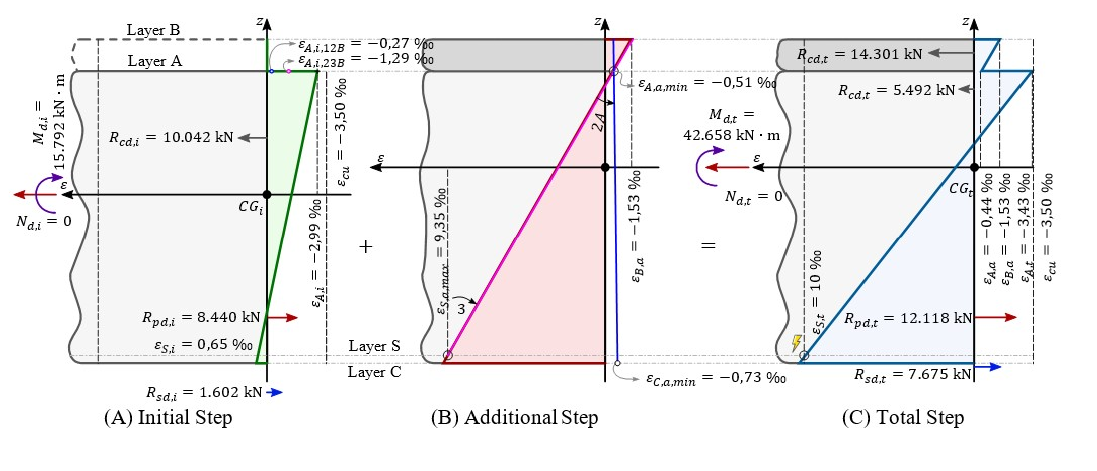
Figure 18. Strain diagram in ULS for the example assuming two casting steps.